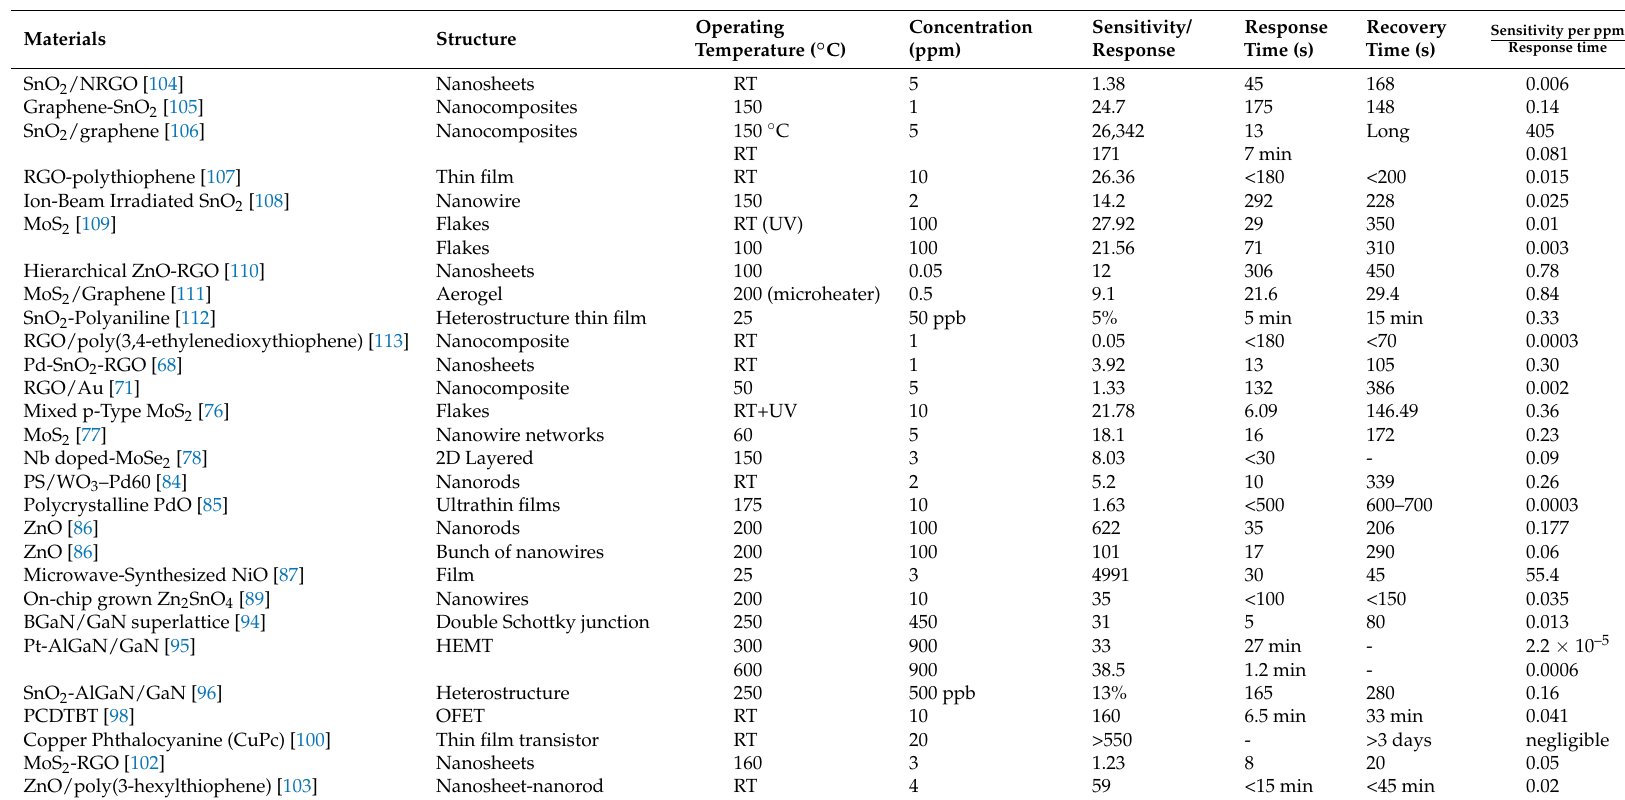
Table 1. Gas sensing properties of recently developed NO 2 gas